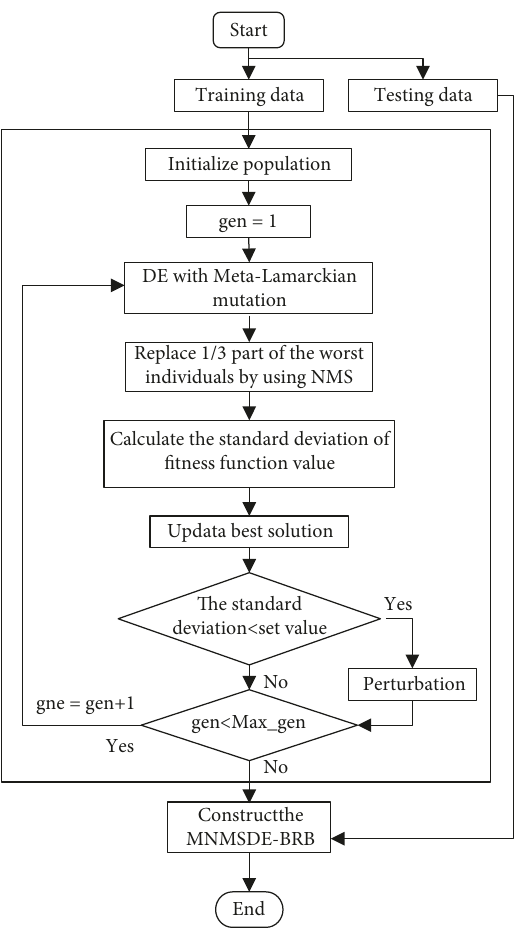
Figure 4: Schematic diagram of